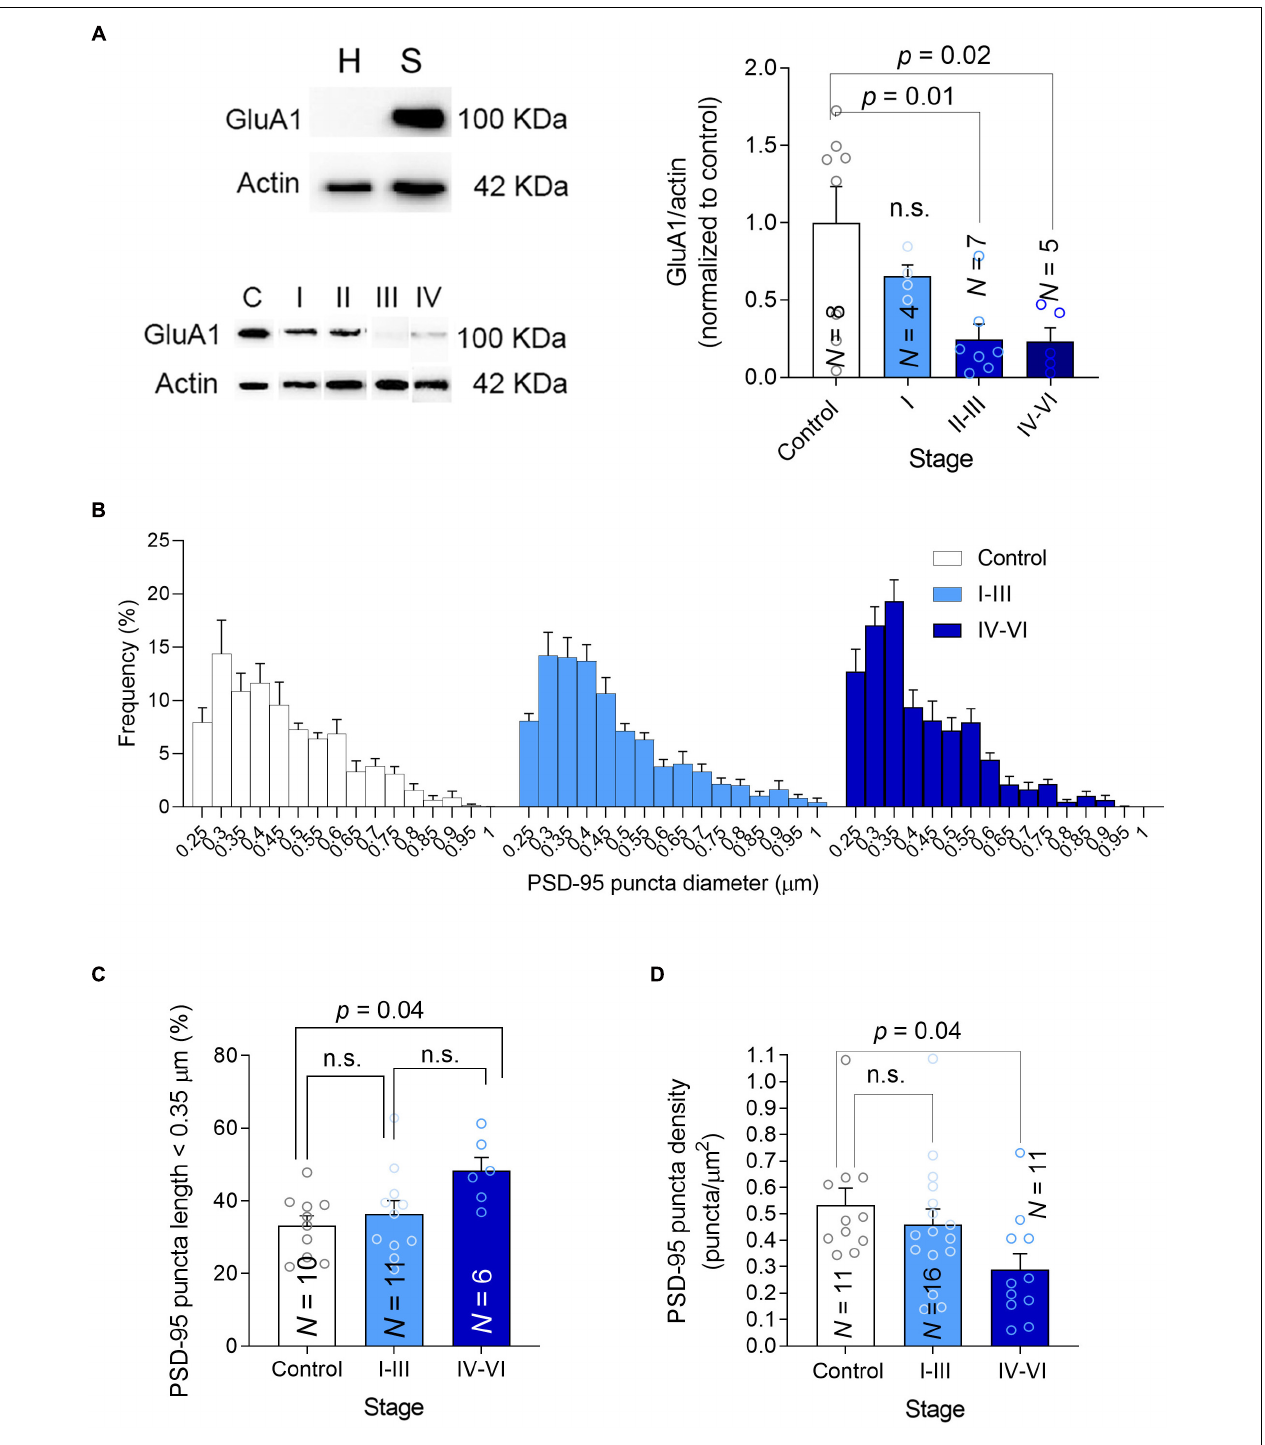
FIGURE 4 | Synaptic GluA1, size and density. (A) Left-top, Hippocampal homogenates (H) were fractionated into crude synaptosomes (S), and the efficacy of fractionation was tested in western blots probed for the GluA1 AMPAR subunit as a synaptic marker. Left-bottom, A western blot showing the PTEN in synaptosomes, using actin as a loading control. Right, The average GluA1 in synaptosomes was determined in western blots. (B) Frequency size distribution of the PSD-95 puncta. (C) Bar graph showing the proportion (%) of small PSD-95 in each group. (D) Bar graph showing the density of PSD-95 puncta. In all the graphs, N is the number of patients and the data are presented as average ± SEM. P -values were determined by One Way ANOVA followed by Tukey’s multiple comparisons test.